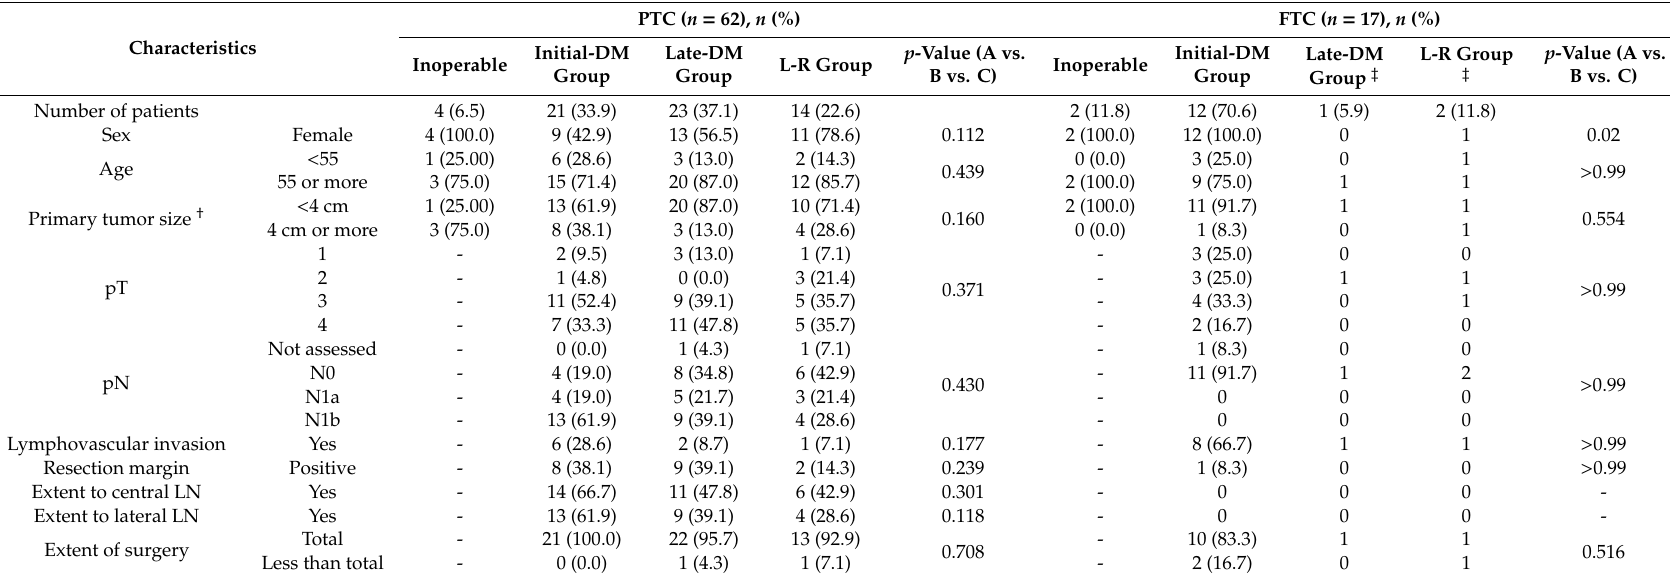
Table 4. Comparison of PTC with FTC according to clinical